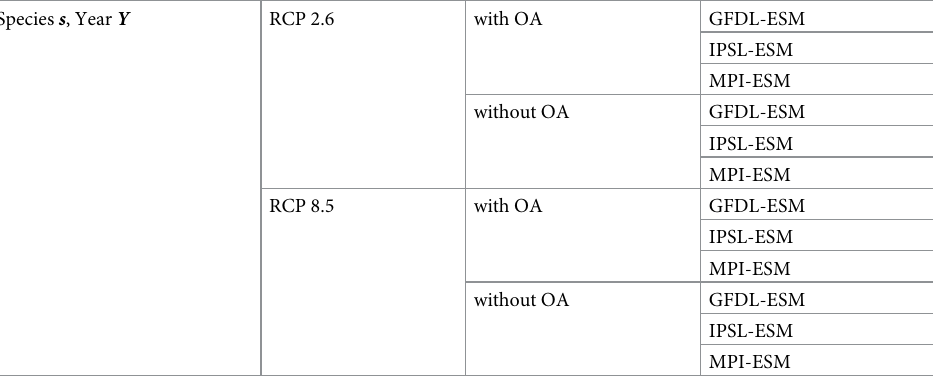
Table 1. Schematic representation of data configuration for each species, s . Each of the 12 configurations yielded a separate global distribution of catch potential in half-degree latitude by half-degree longitude cells for each year, Y that was modelled